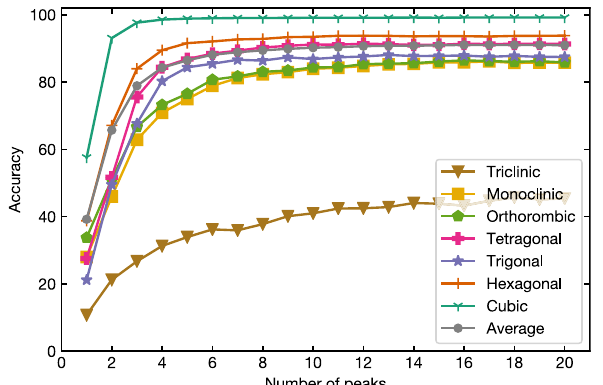
Figure 5. Classification accuracy versus number of peak positions used in